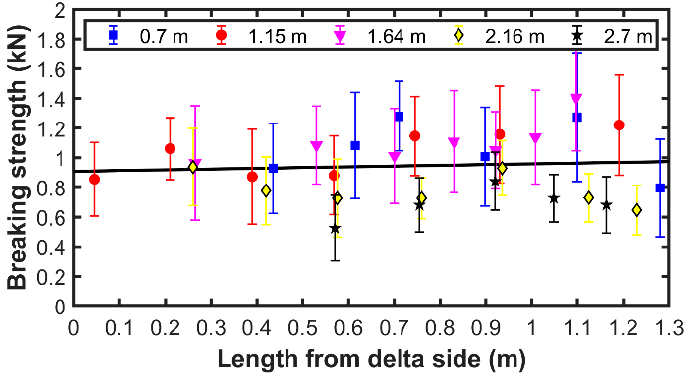
Figure 10. Average measured compressive breaking strength (markers), as a function of length below the contact shoes and distance from the delta side of the electrode, as well as a single linear fit of this data (line).